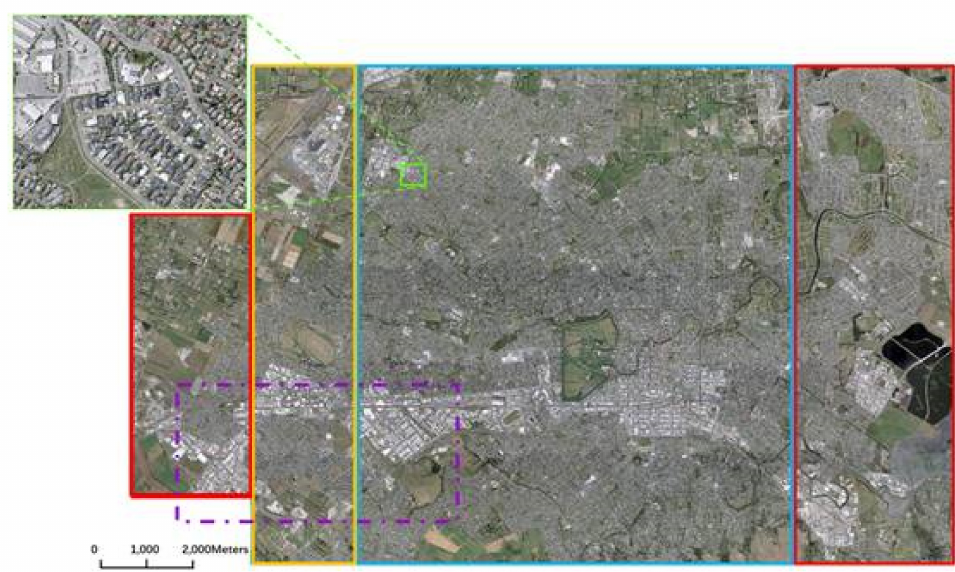
Figure 7. WHU dataset (blue box: training area, green box: validation area, red boxes: test